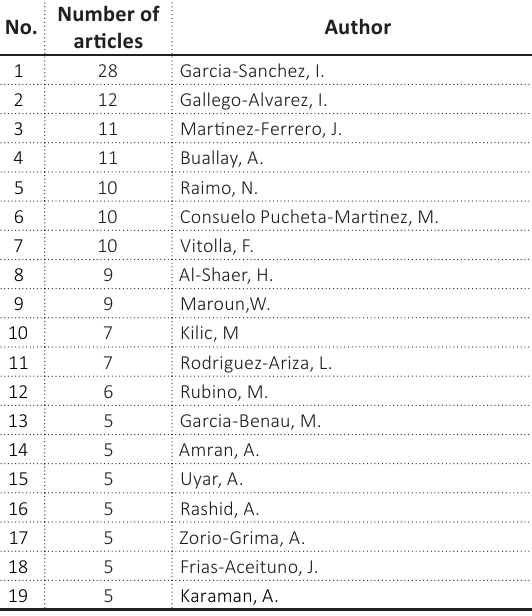
Table 5. Number of articles published by authors Number of No.